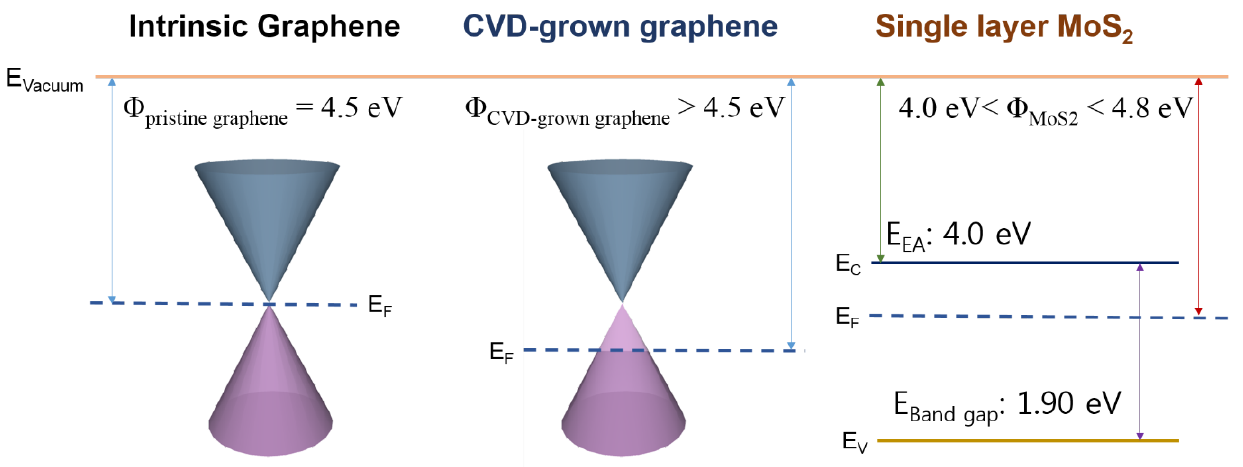
Figure 2. Schematic band diagram of intrinsic graphene, CVD-grown graphene, and single-layer MoS 2 .